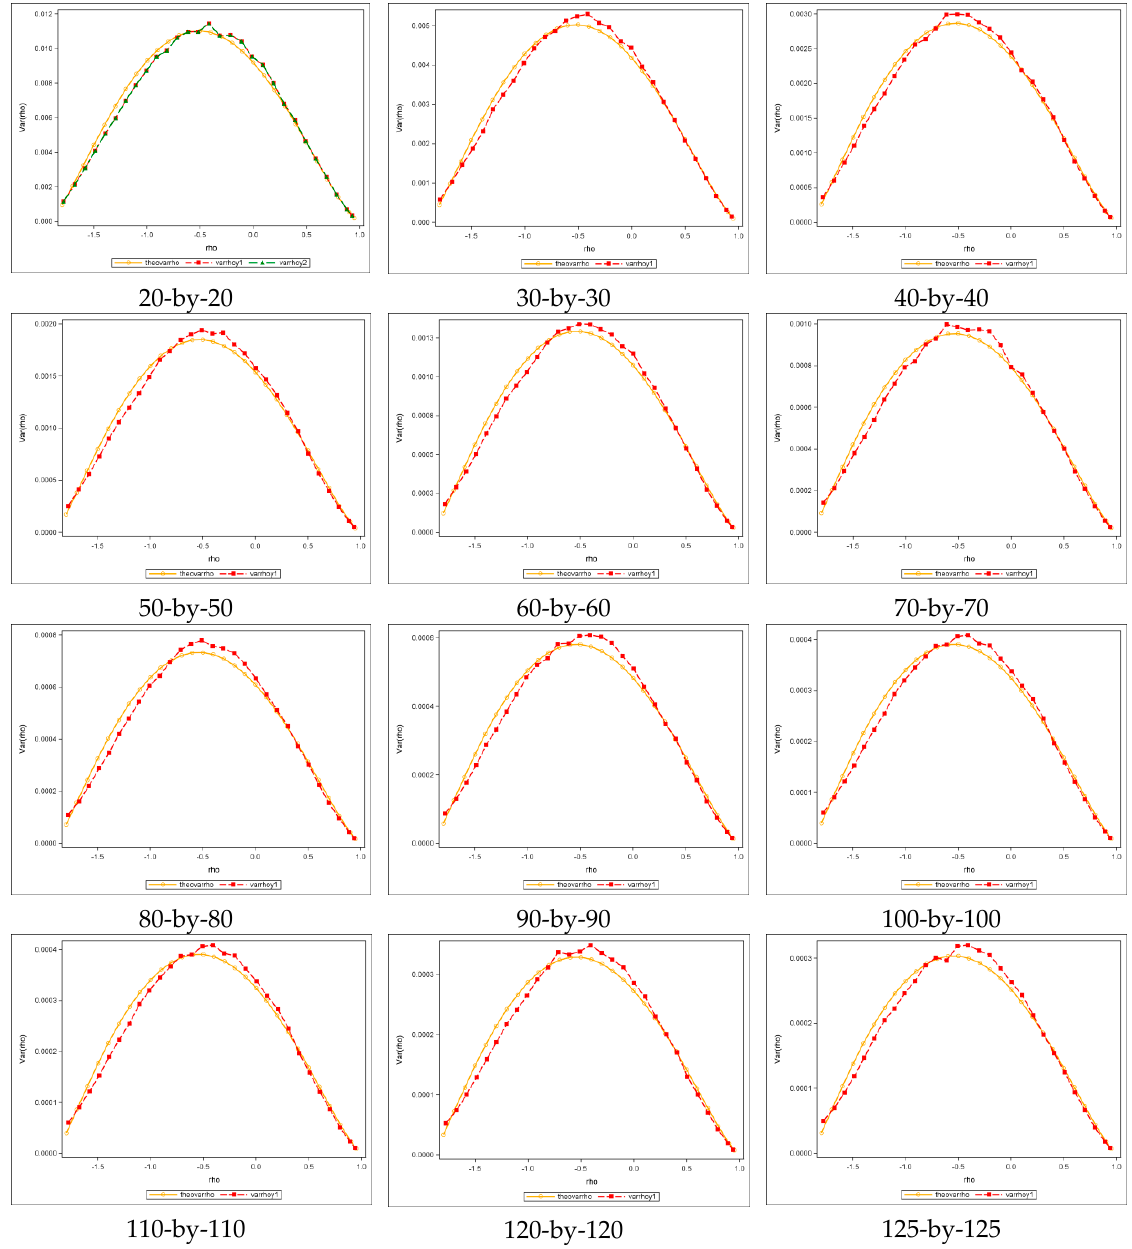
Figure A5. Theoretical variances (orange) versus exact variances (red and green) obtained by approximating the Jacobian term and employing new MLEs with different sample sizes for the square tessellation with queen adjacency.